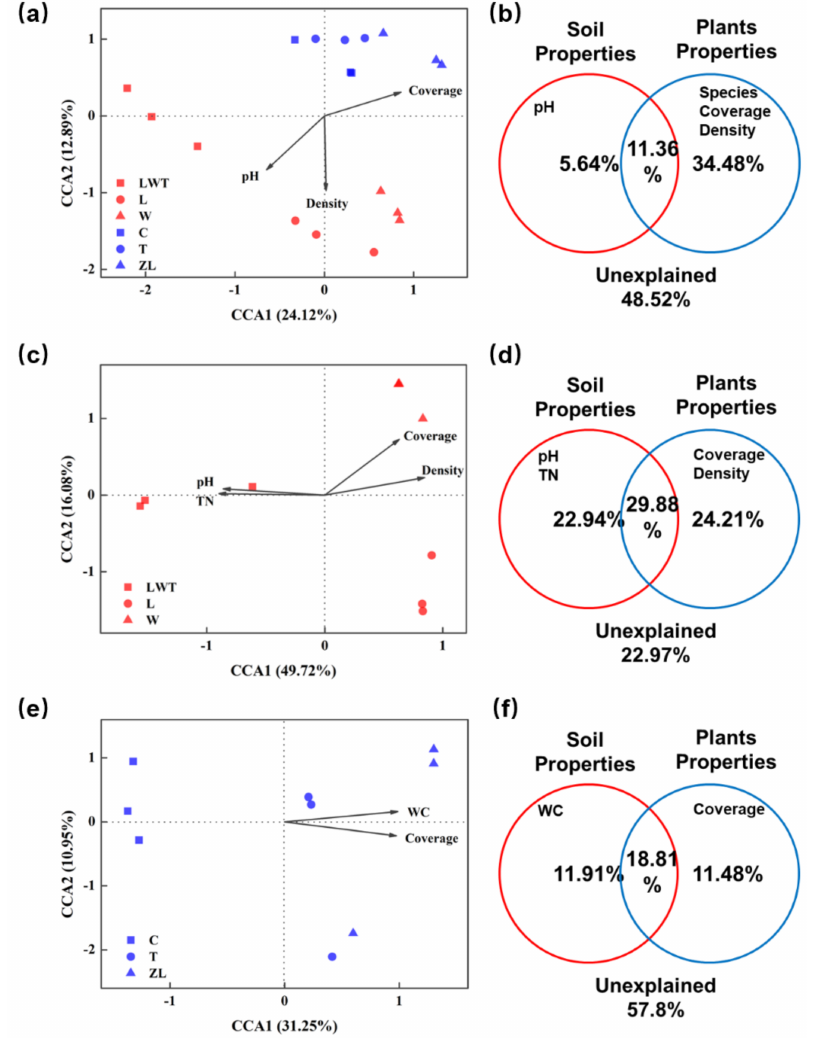
Figure 12. CCA and VPA analysis based on selected environmental variables and GeoChip microarray detected N and C cycling-related functional gene abundances in samples from Phragmites and Carex sites ( a , b ), selected samples from Phragmites sites alone ( c , d ) and Carex sites alone ( e , f ). The percentage values of axis 1 and 2 in CCA indicate the percentage of variation explained by the corresponding axes. Environmental variables in VPA are divided into groups of soil and plant properties. The variance unexplained by the tested variable groups is indicated in the VPA